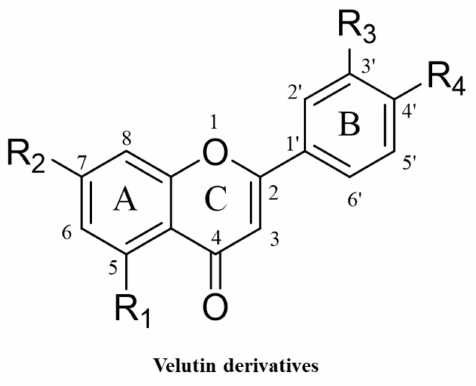
Figure 1. The chemical structure of